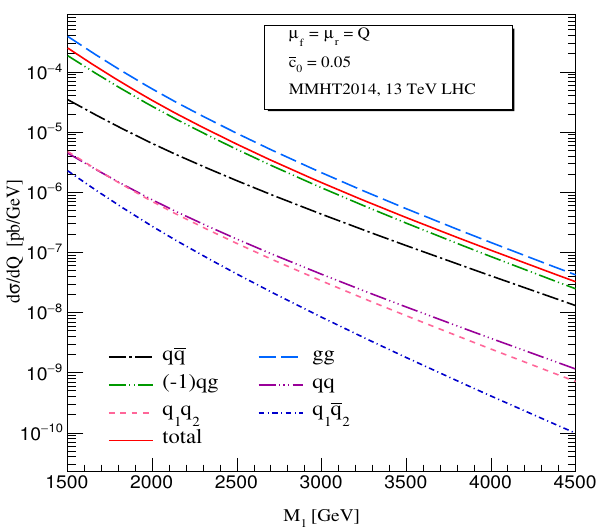
Figure 1 . Di(cid:11)erent subprocess contributions for the RS model at NNLO QCD right at the reso- nance for di(cid:11)erent M 1 values keeping (cid:22) c 0 (cid:12)xed at 0 : 05.